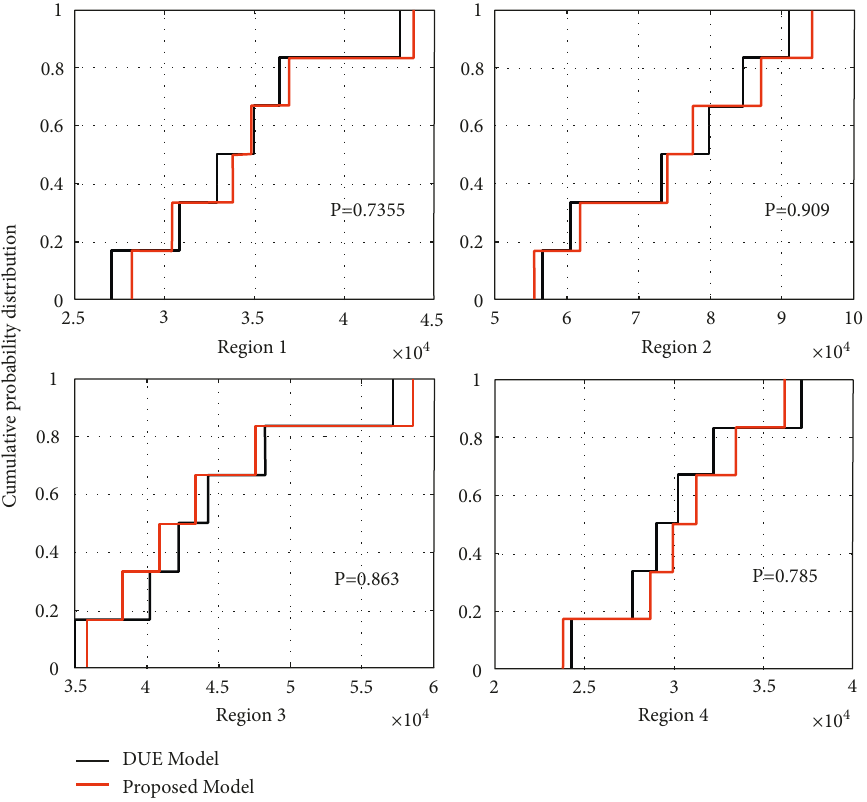
Figure 8: K - S test results for different MFD dynamics.